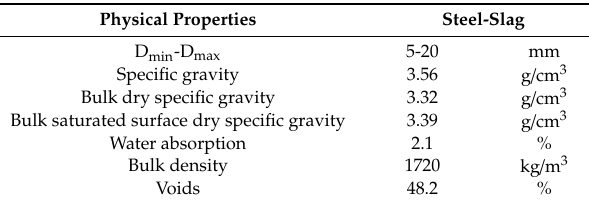
Table 3. Physical properties of steel-slag material.